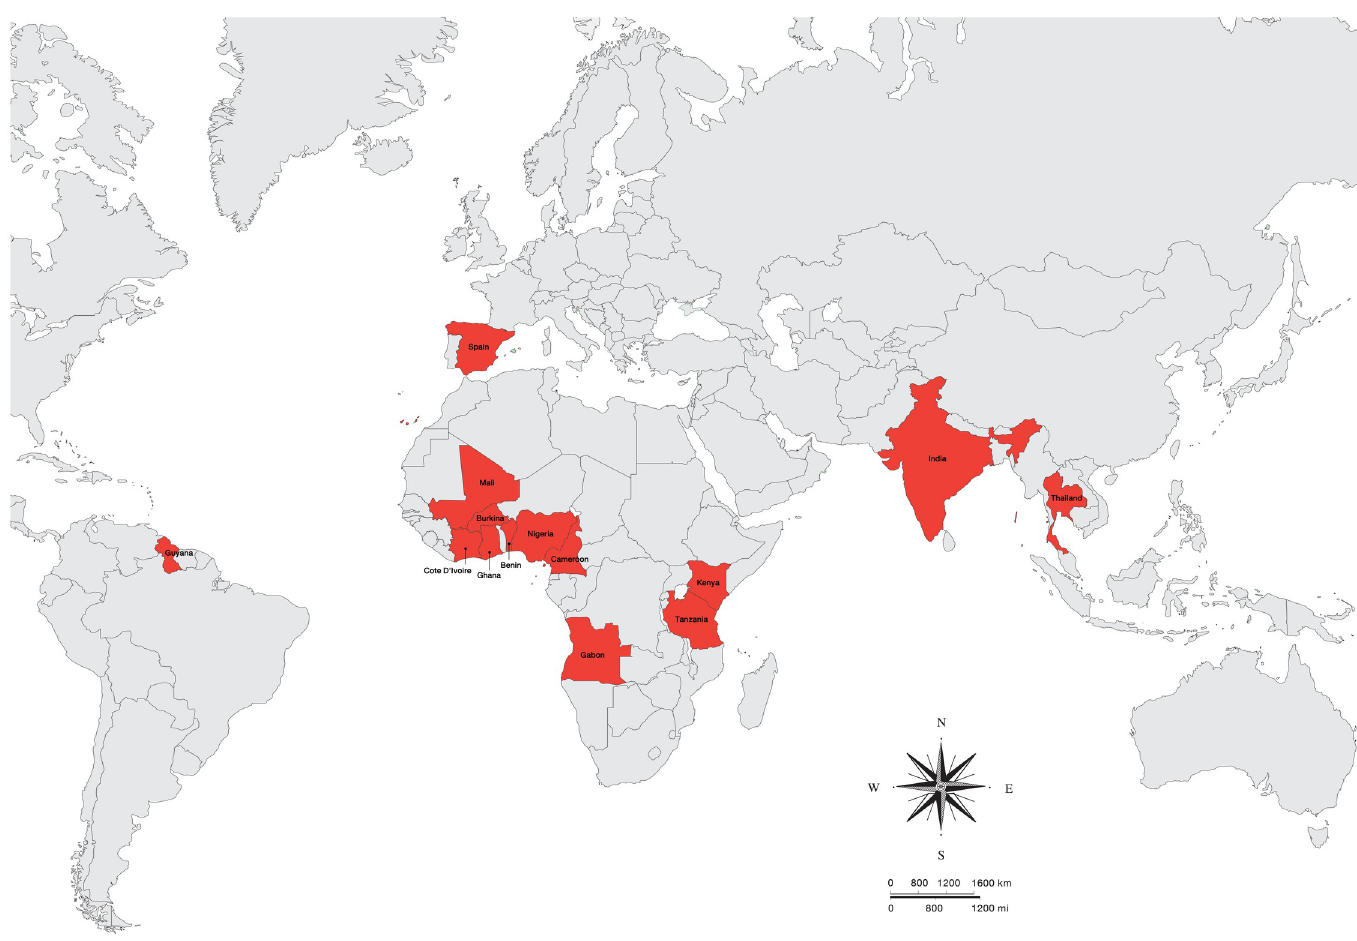
Fig 2. Geographic distribution of malaria and filariasis co-infections. The crimson color indicated countries where co-infections were reported.